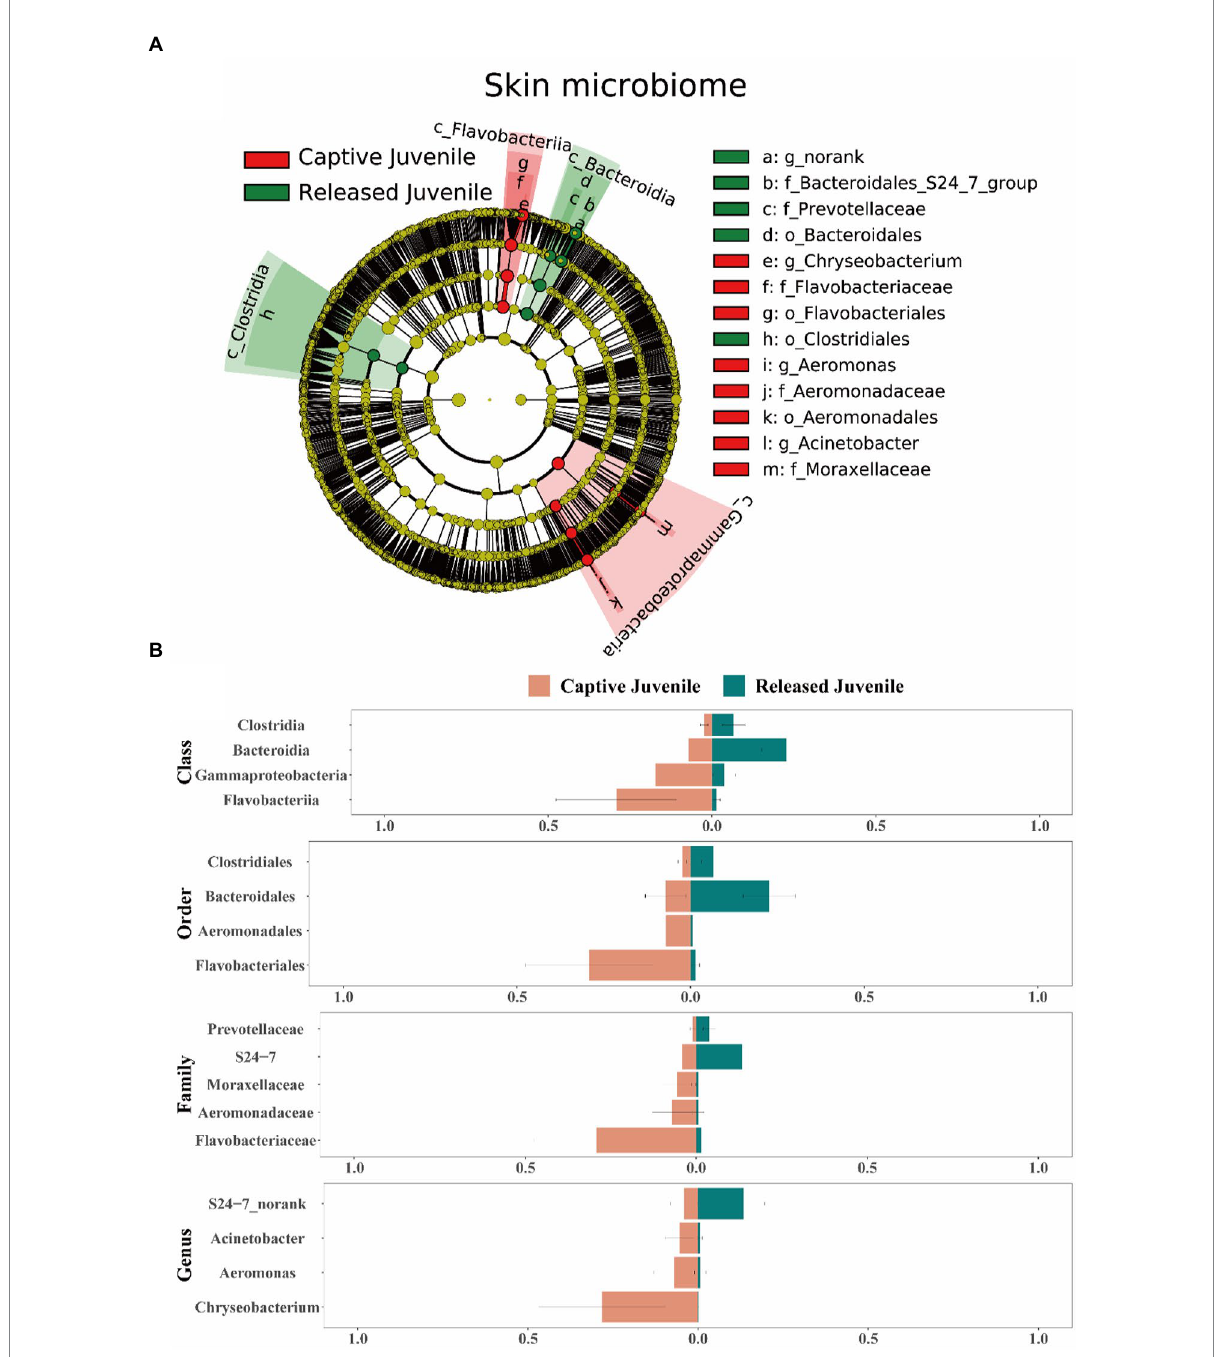
FIGURE 6 Difference of the skin microbiota between captive bred and released juveniles. (A) A LEfSe analysis identifies the different abundant skin bacterial taxa between captive bred and released juveniles. (B) Side-by-side comparison of the mean relative abundance of different abundant skin bacterial taxa between captive bred and released juveniles at class, order, family, and genus levels. Data are presented as means ± SE in bar